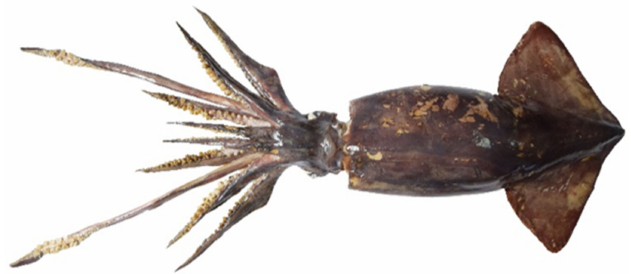
Figure 2. Appearance of S. oualaniensis .